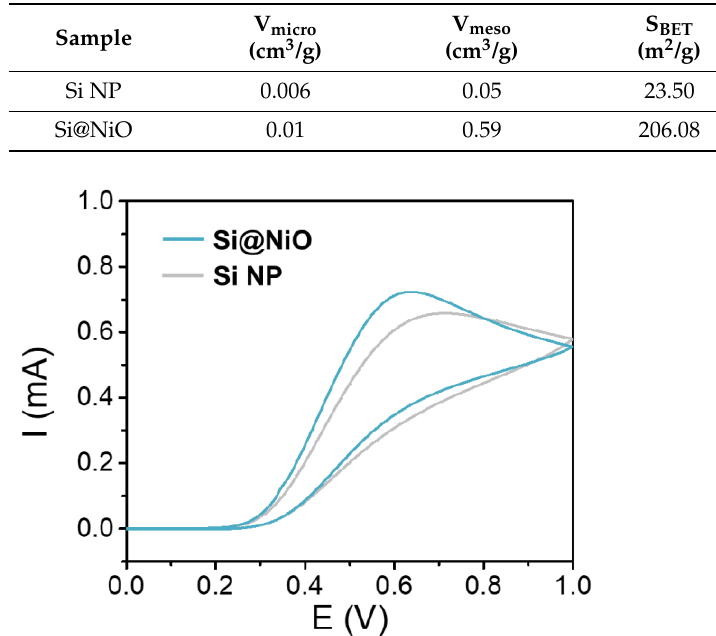
Figure 4. Electrochemical characterization. CV curves of Si NP and Si@NiO acquired in PBS containing 0.1 M AA; scan rate: 100 mVs −1 .